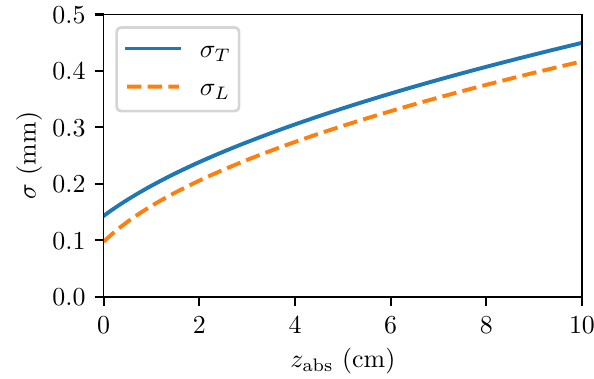
Fig. 1 The dependence of the transverse width σ T (solid blue line) and the longitudinal width σ L (dashed orange line) on the drift distance z abs for the simulated TPC. The offset at z abs = 0 is due to the amplification resolution term A T . The measured widths will include an additional contribution from the digitization resolution of the